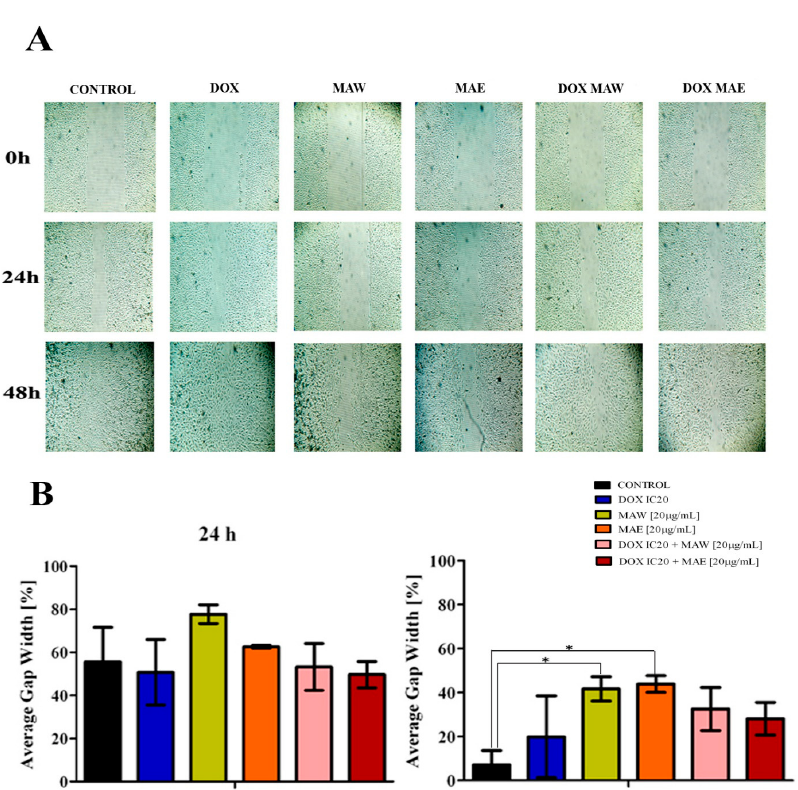
Figure 2. Effects of M. aquifolium extracts and DOX on migration of A549 cells. The cells were treated with DOX IC20, MAW (20 µ g / mL), MAE (20 µ g / mL), or their combinations. ( A ) Representative images of one of three independent experiments. ( B ) Quantitative analysis of results presented in (A).